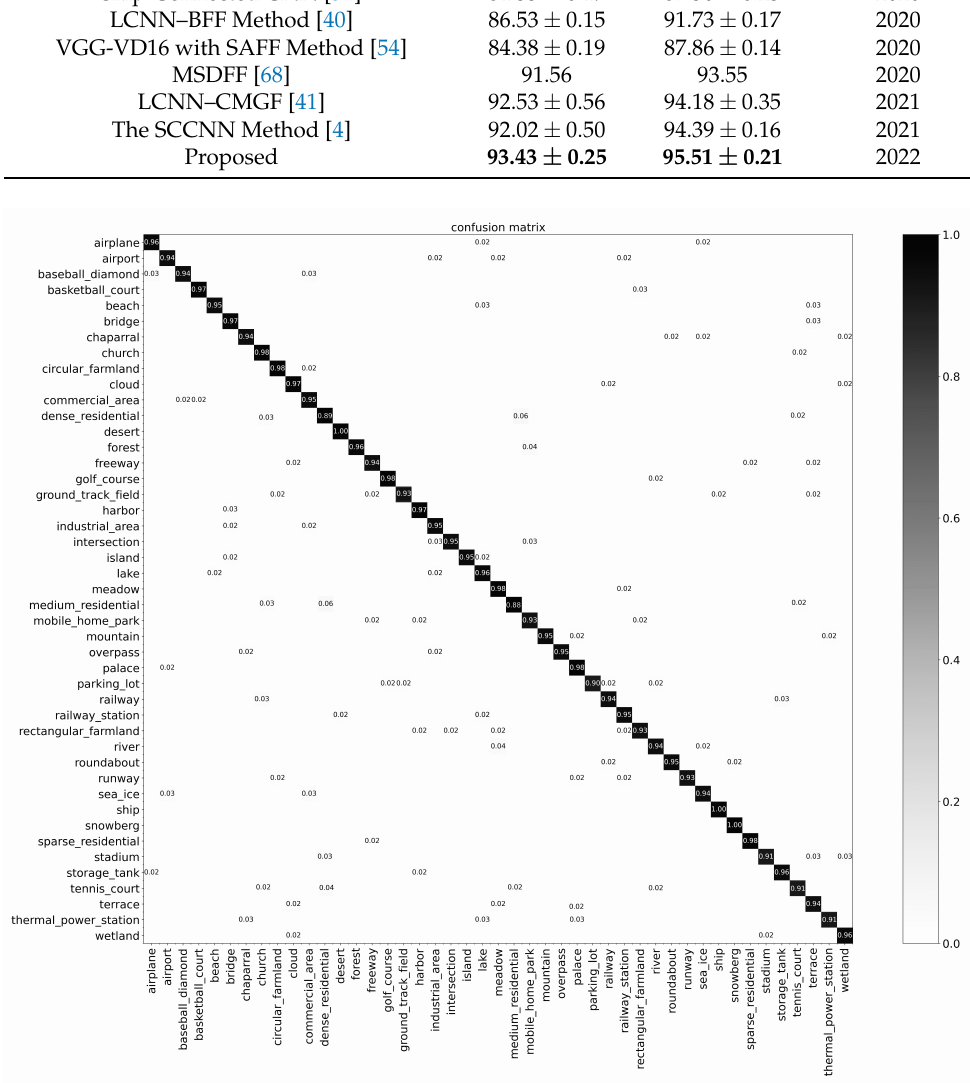
Figure 17. Confusion matrix of our model on NWPU dataset (train:test =